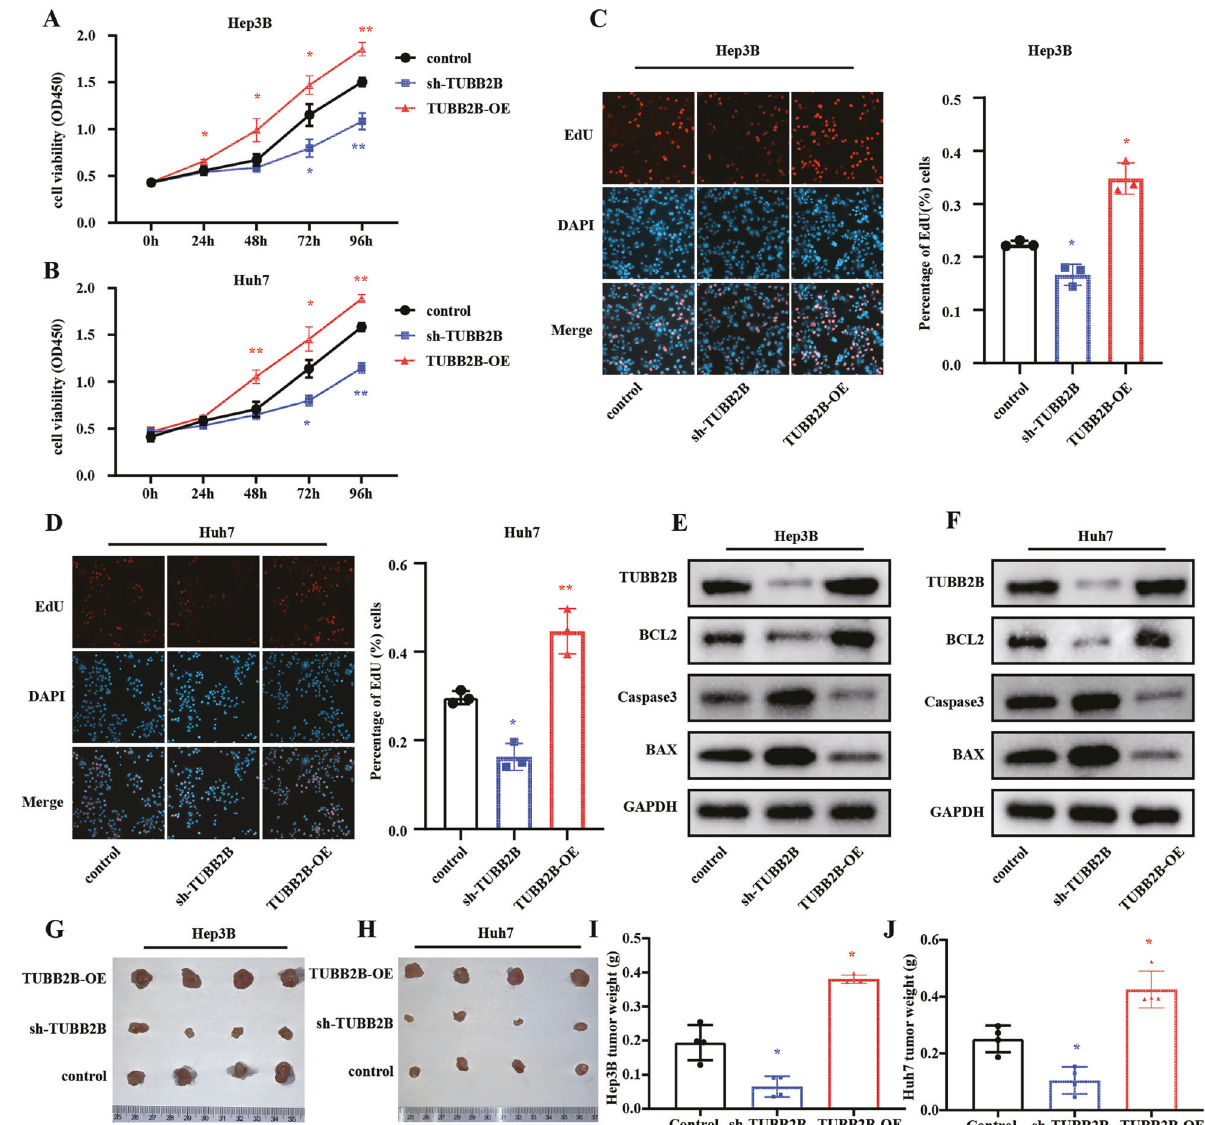
Fig. 2 TUBB2B de fi ciency suppresses HCC proliferation, and promotes apoptosis in vitro and in vivo. A – D The function of TUBB2B on cell proliferation was determined by CCK8 assay and EdU quanti fi cation in Hep3B and Huh7 cells ( n = 3/per group). E , F Effects of TUBB2B on apoptosis biomarkers ( n = 3/per group). G , H Image of Hep3B and Huh7 xenografted mice sacri fi ced at 1 month ( n = 4/per group). I , J Tumor weight in control, sh-TUBB2B, and TUBB2B-OE groups are shown ( n = 4/per group). Experimental group compared to control group: * p < 0.05, ** p <